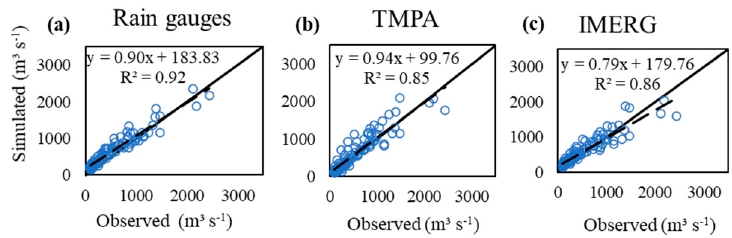
Figure 5. Scatter plots of the observed and simulated streamflows using different precipitation data sources. data sources.